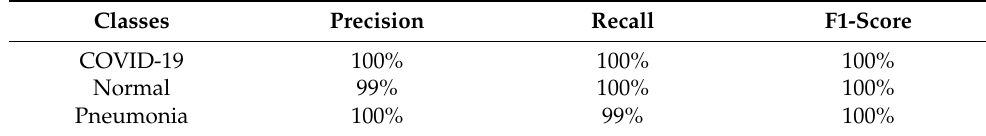
Figure 5. Confusion matrix of X-ray modality. Table 5. The classification report of our proposed approach on X-ray modality.